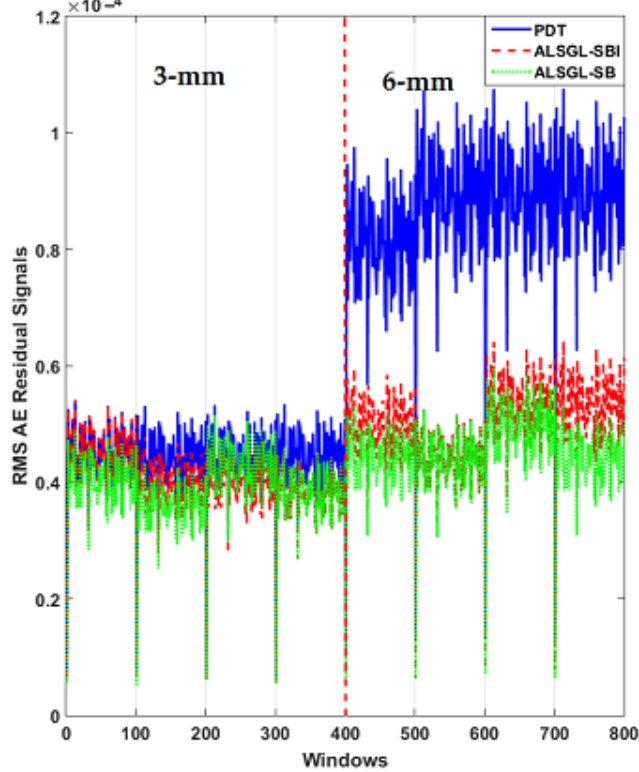
Figure 17. RMS of resampled AE residual signals for crack size (3 mm and 6 mm) diagnosis for ball conditions using ALSGL-SB, ALSGL-SBI and PDT methods.